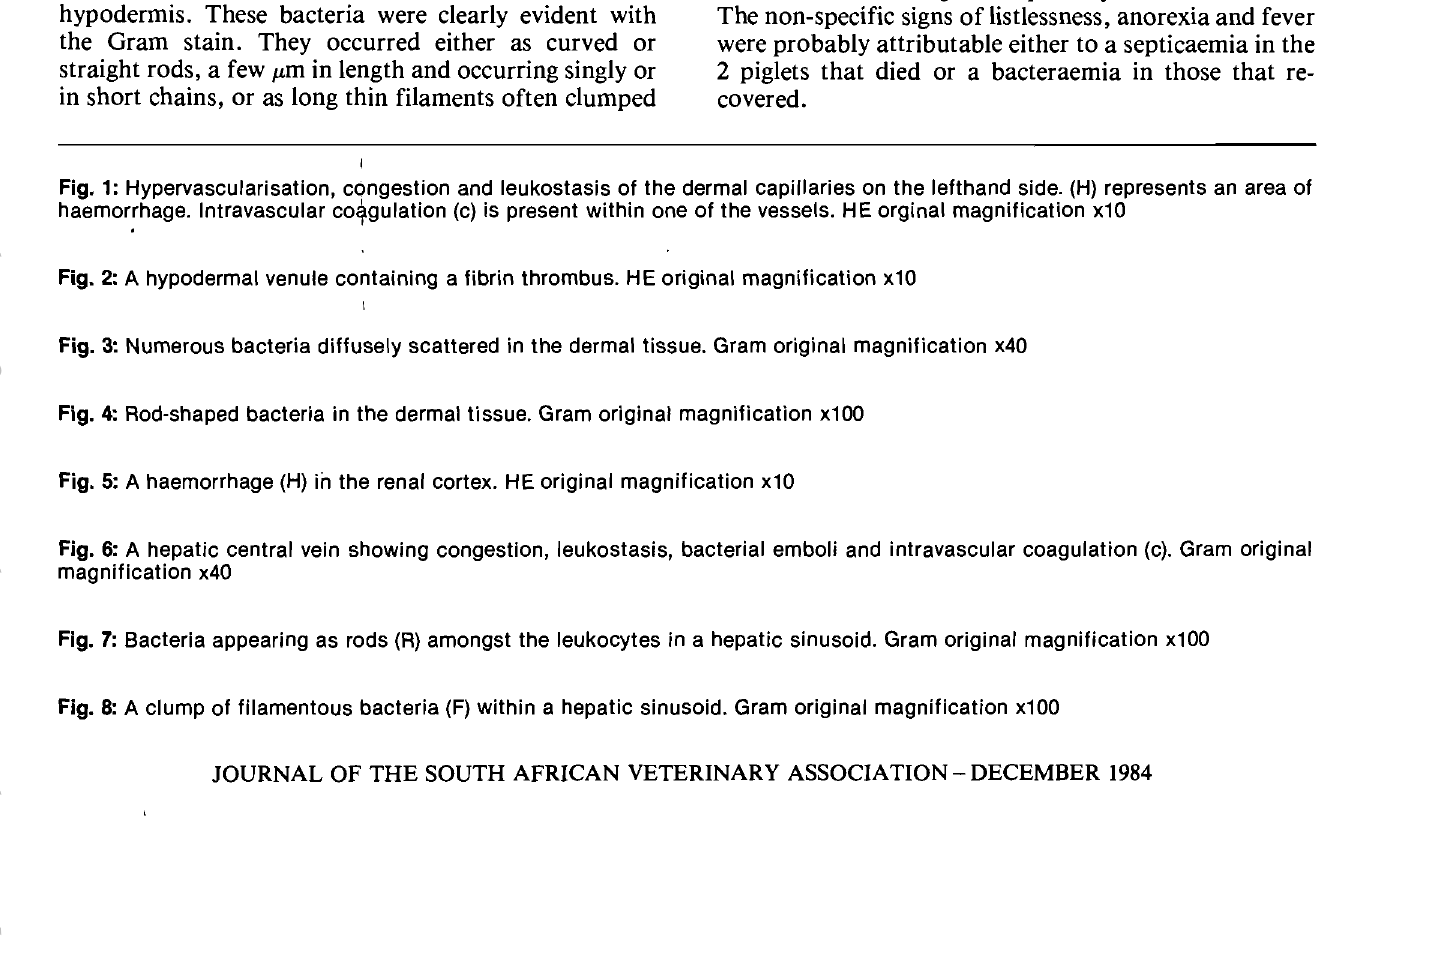
Fig. 1: Hypervascularisation, congestion and leukostasis of the dermal capillaries on the lefthand side. (H) represents an area of haemorrhage. Intravascular co*gulation (c) is present within one of the vessels. HE orginal magnification x10 Fig. 2: A hypodermal venule containing a fibrin thrombus. HE original magnification x10 Fig. 3: Numerous bacteria diffusely scattered in the dermal tissue. Gram original magnification x40 Fig. 4: Rod·shaped bacteria in the dermal tissue. Gram original magnification x100 Fig. 5: A haemorrhage (H) in the renal cortex. HE original magnification x10 Fig. 6: A hepatic central vein showing congestion, leukostasis, bacterial emboli and intravascular coagulation (c). Gram original magnification x40 Fig. 7: Bacteria appearing as rods (R) amongst the leukocytes in a hepatic sinusoid. Gram original magnification x100 Fig. 8: A clump of filamentous bacteria (F) within a hepatic sinusoid. Gram original magnification